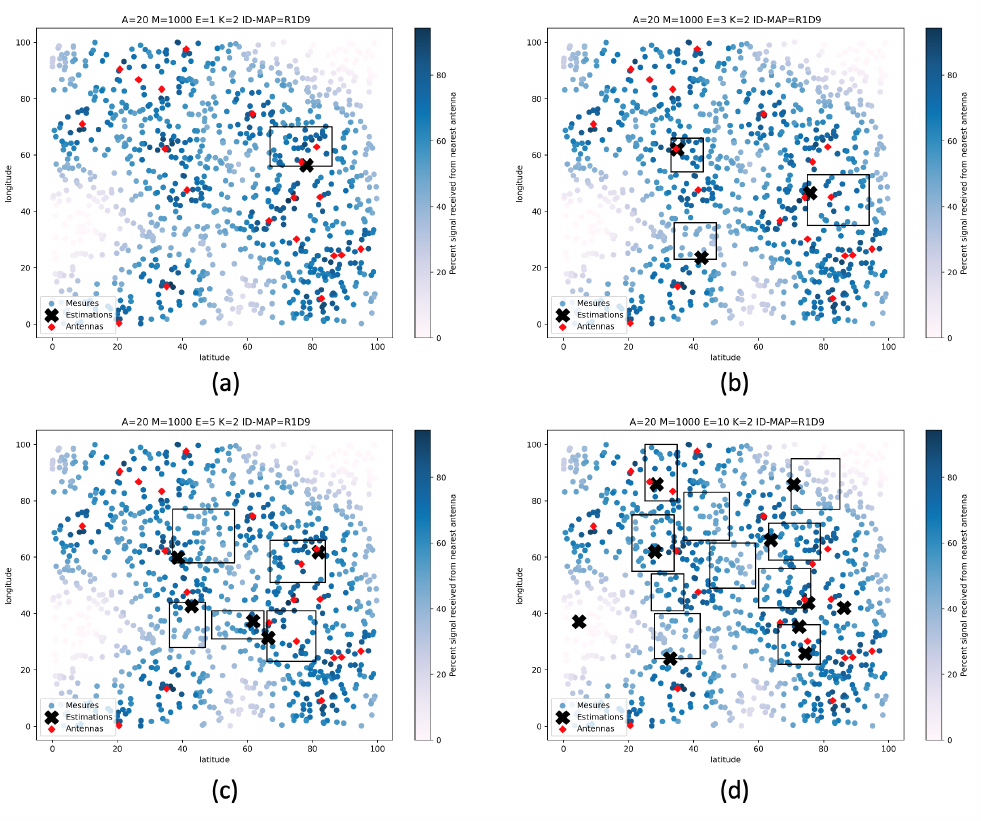
Figure 16. Proposed deployments after 50 iterations on 1, 3, 5, and 10 areas of interest without ob- stacles ( a ) 1 area of interest, ( b ) 3 areas of interest, ( c ) 5 areas of interest, ( d ) 10 areas of